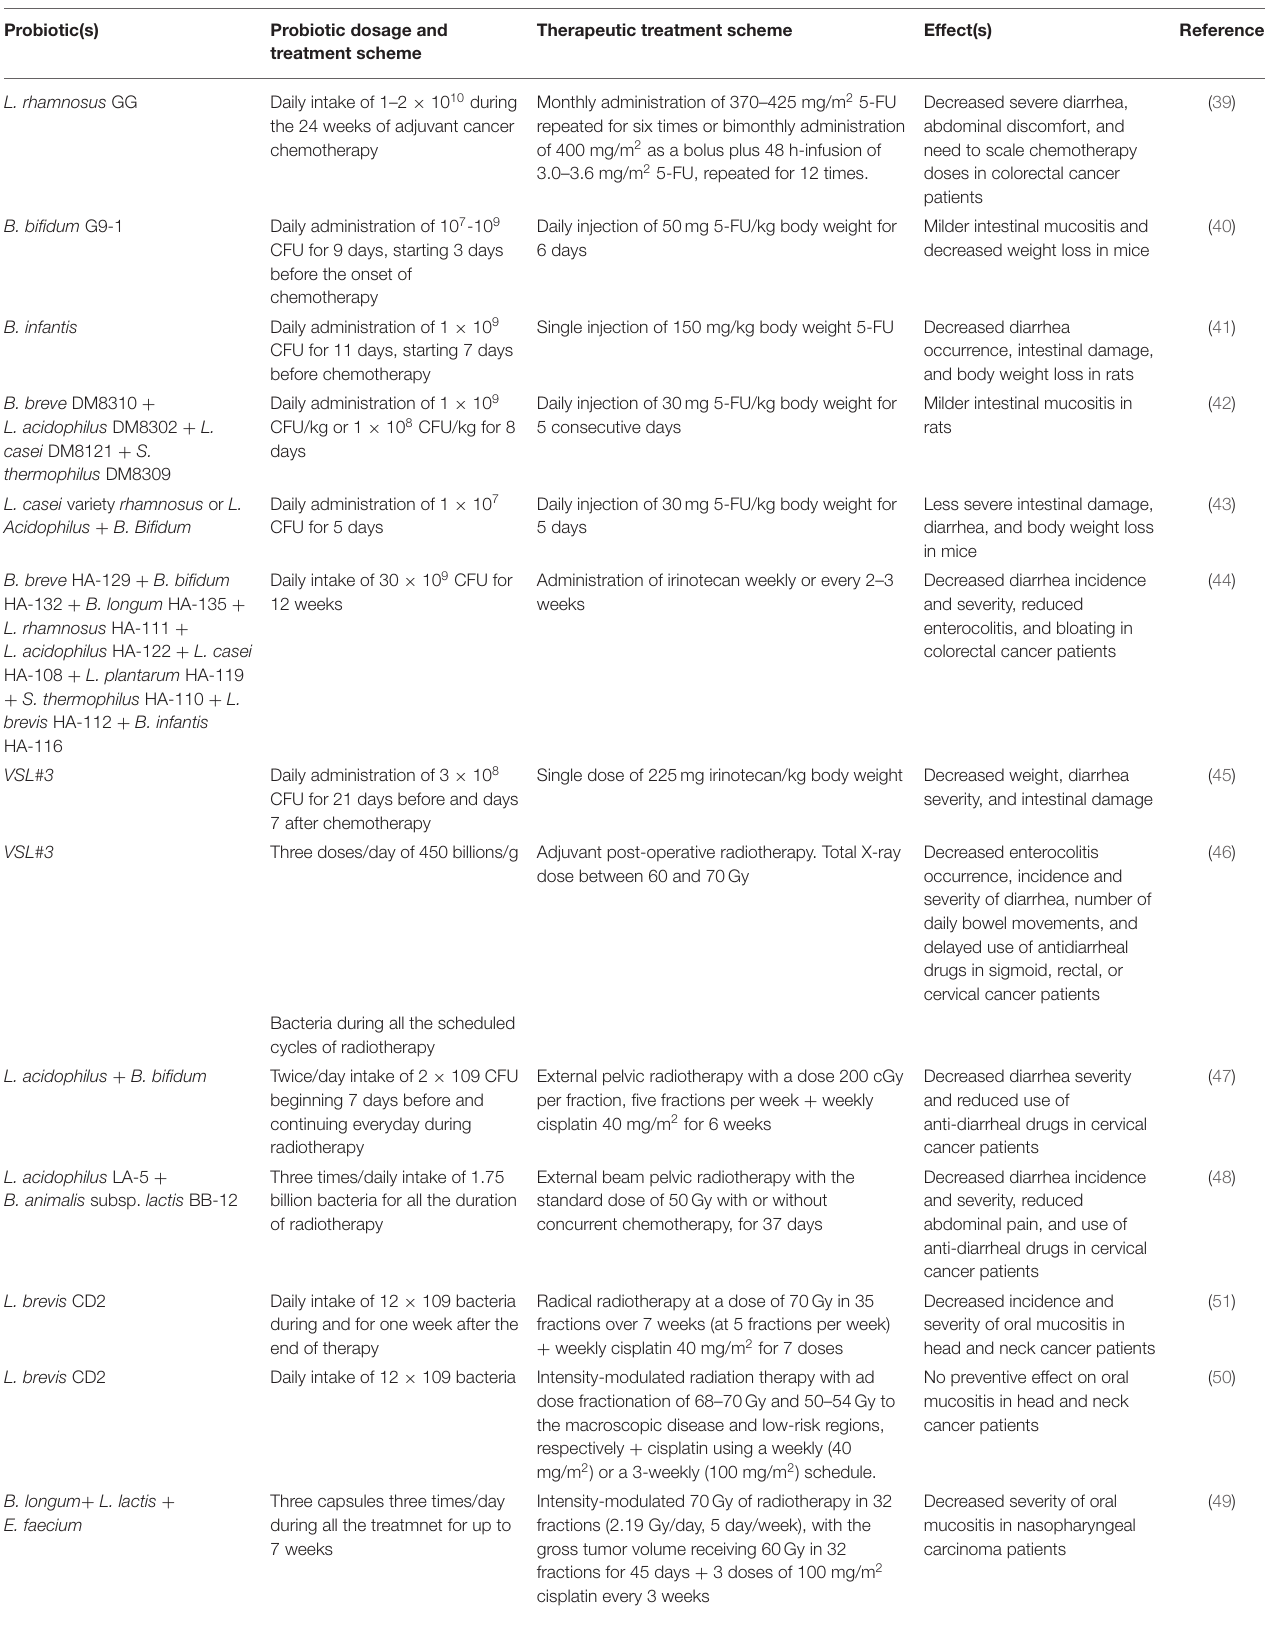
TABLE 2 | Effects of probiotic intake on anticancer therapies’